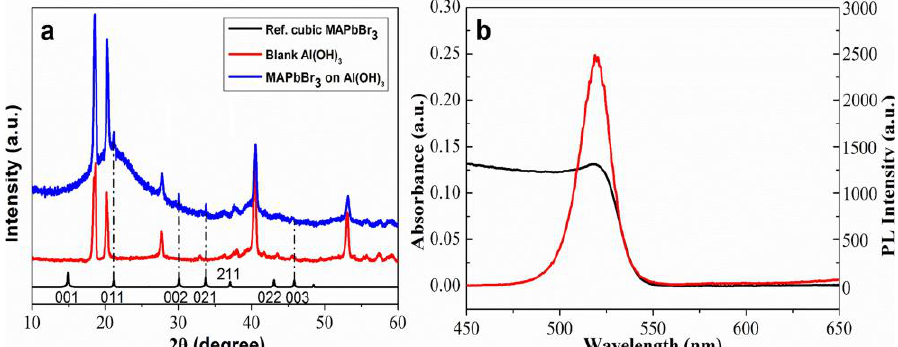
Figure 3. ( a ) X-ray diffraction pattern of MAPbBr 3 perovskite on-site grown on the Al(OH) 3 -SH layer and ( b ) the absorbance and emission spectra of synthesized MAPbBr 3 perovskite.